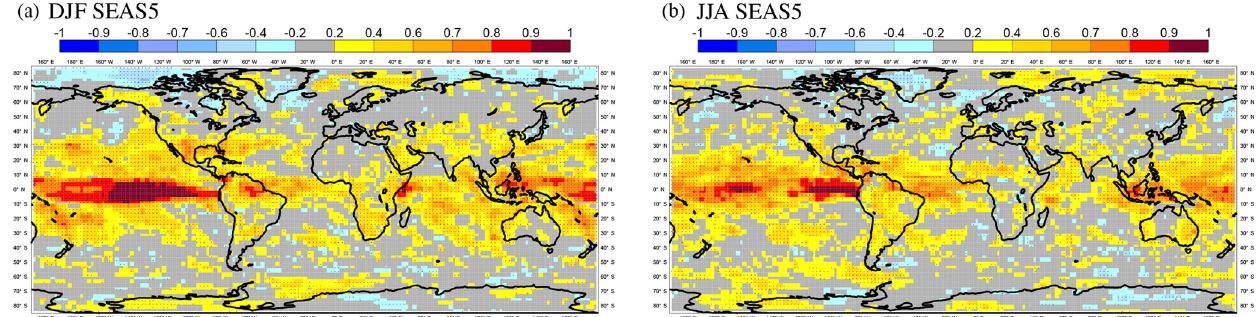
Figure 20. Anomaly correlation maps of the SEAS5 ensemble-mean precipitation forecast for DJF (a) and JJA (b) at 1 month forecast lead. Precipitation is verified with GPCP v2.2 data from 1981 to 2014. Locations with correlation values different from zero at the 5% significance level are highlighted by